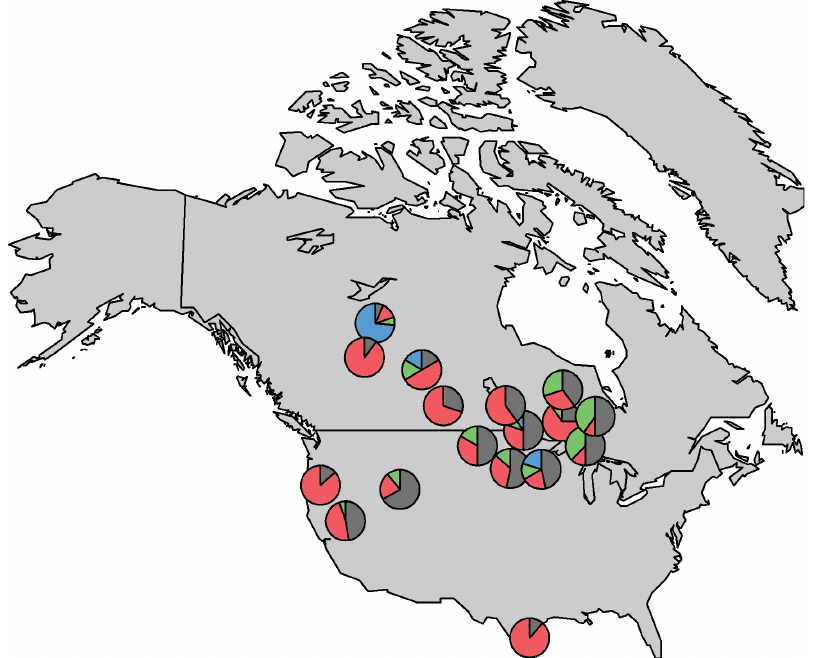
Fig 3. Cluster Membership Map. Proportion of feather samples from pelicans at 17 breeding colonies that fall into one of four clusters, based on k-means cluster analysis. The four colours (grey, red, blue, green) represent the proportion of samples assigned to each of the four different clusters defined by the clustering algorithm. Some colony locations have been slightly offset for better